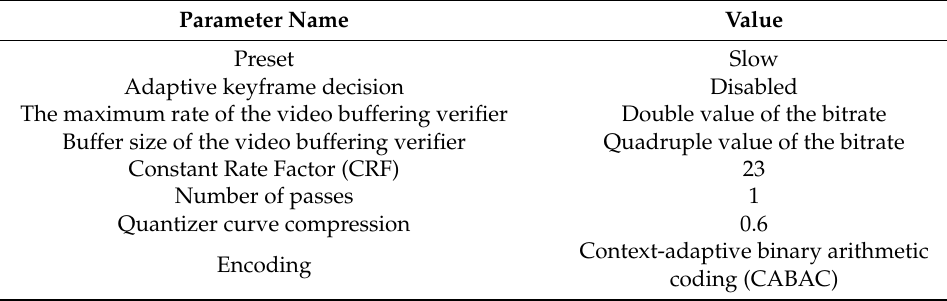
Table 2. Selected encoding